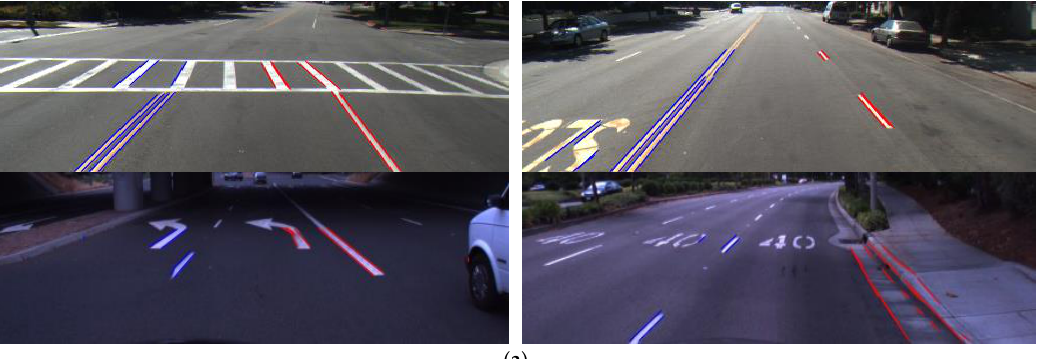
Figure 20. Correct lane detection: ( a – d ) Caltech dataset (( a ) Cordova 1; ( b ) Cordova 2; ( c ) Washington 1; ( d ) Washington 2); ( e ) SLD dataset; ( f ) Road marking dataset.